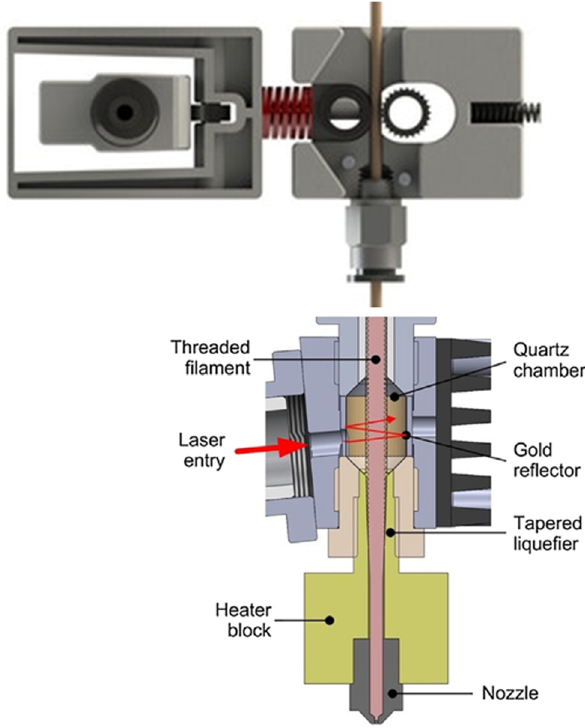
Figure 5: The feeding of threaded fi lament and the laser - assisted heating chamber. Adopted from ref. [ 80 ] with modi fi